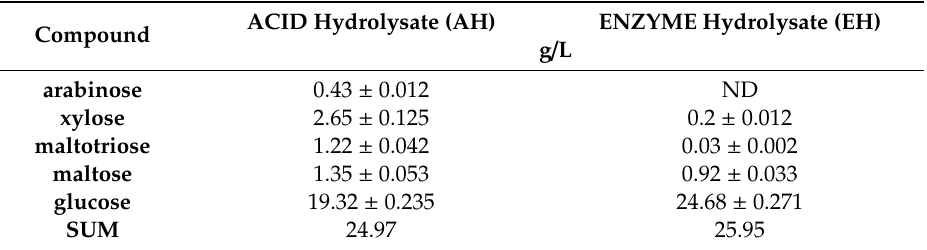
Table 1. Selected sugar content in potato waste pulp